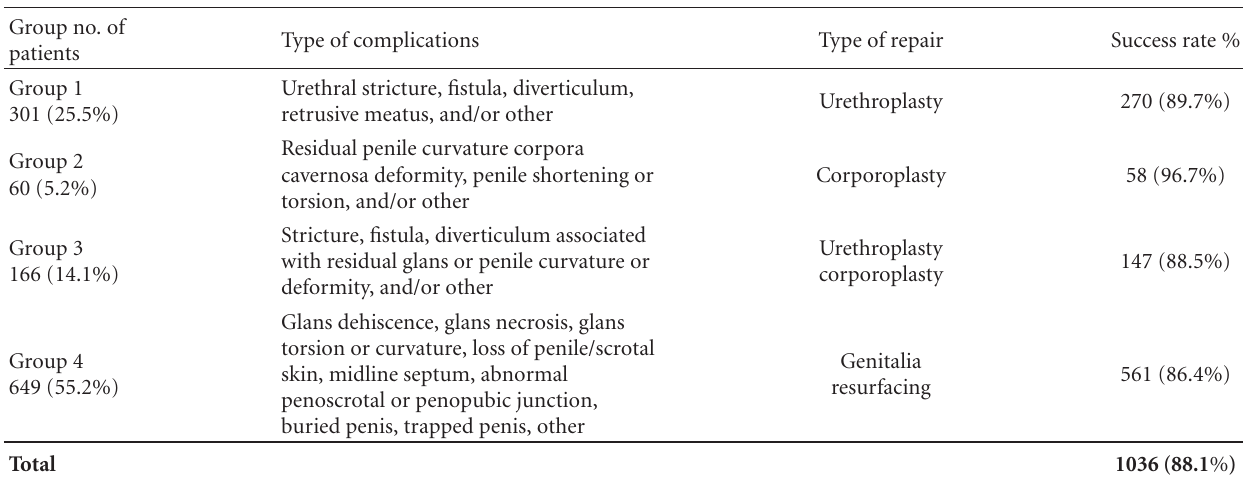
Table 1: Success rate according to the complication and repair.